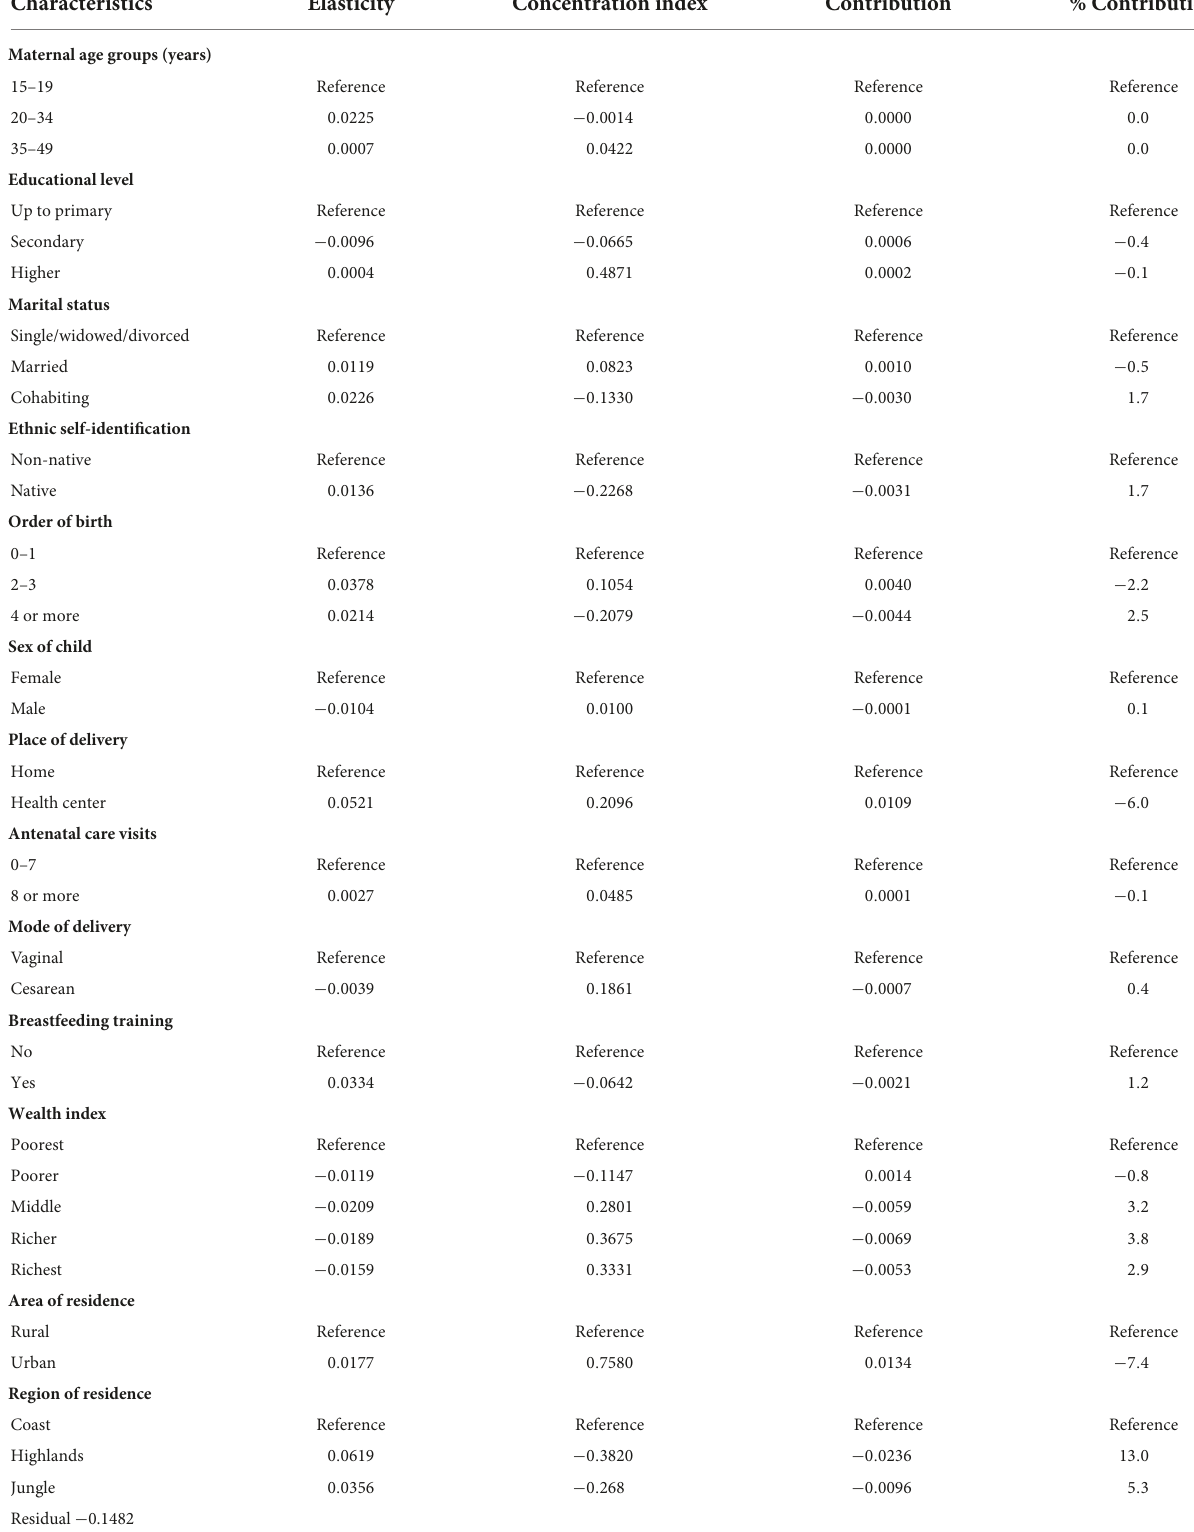
TABLE 4 Decomposition of concentration indices of exclusive breastfeeding (EBF) among infants between 6 and 59 months of age.